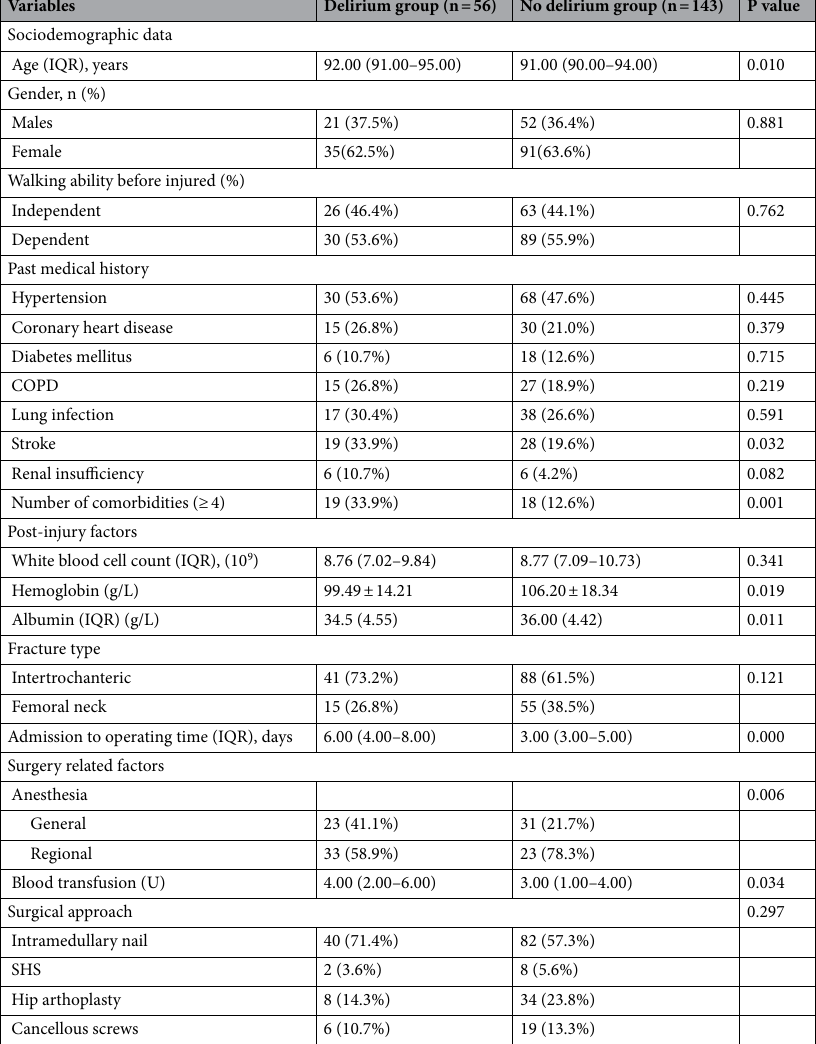
Table 2. Factors of cohort, categorized by presence or absence of postoperative delirium. IQR interquartile range, COPD chronic obstructive pulmonary diseases, SHS sliding hip screw.